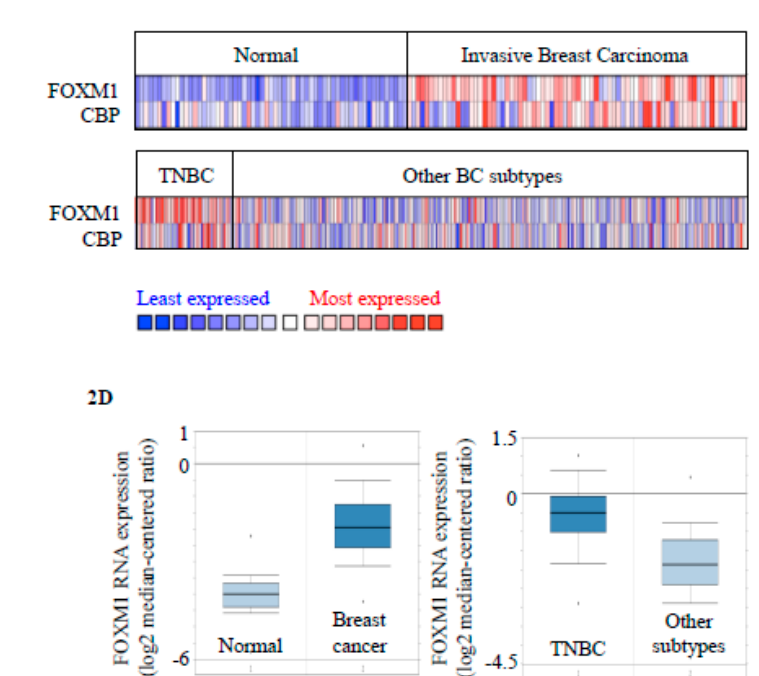
Figure 2. Chemical-genomic approach identifies FOXM1 as a downstream effector of CBP signaling in TNBC. ( A ) Whole transcriptome RNA Seq data volcano plot of differentially expressed genes in MDA-MB-231 treated with 10 µ M ICG-001 or DMSO vehicle control (DMSO vs. ICG-001: 1339 differentially expressed genes, 729 genes up-regulated, 610 genes down-regulated FDR ≤ 0.05, ≤ |2-fold| change). ( B ) Ingenuity pathway analysis of RNA Seq data differential gene expression data identifies FOXM1 as an upstream regulatory factor. ( C ) Comparison of CBP and FOXM1 in the TCGA BC data set ( n = 593); top panel: Normal and invasive breast cancer, bottom panel: TNBC and other BC subtypes. Colors are standard scores ( z -scores) to depict relative normalized values within rows and do not allow for comparison of values between rows. ( D ) RNA expression levels of FOXM1 in the TCGA BC data set ( n = 593); left box plot: normal breast tissue compared to BC (4.23-fold BC vs. normal, p = 3.51 × 10 − 30 ), right box plot: TNBC compared to other BC subtypes (2.43-fold TNBC vs. others, p = 1.24 × 10 − 13 ) (Oncomine database).